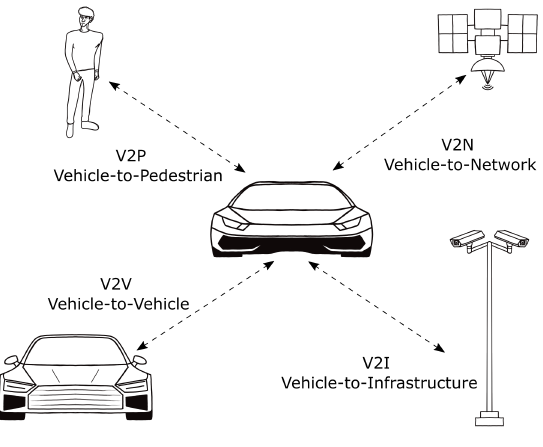
Figure 6. Vehicle communication